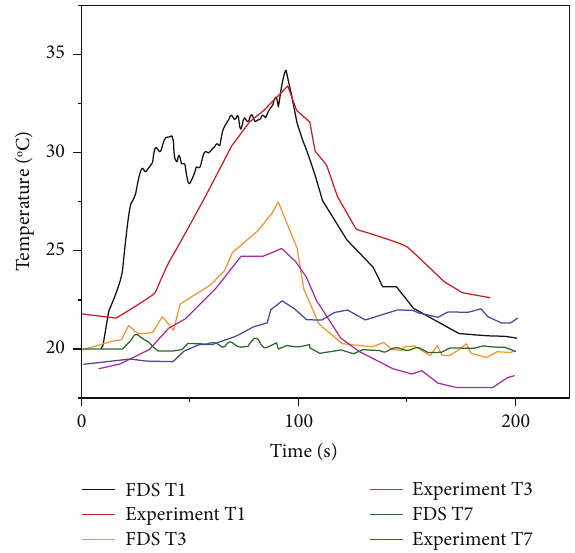
Figure 4: The temperature observed by Zhang et al. vs. the results reproduced by